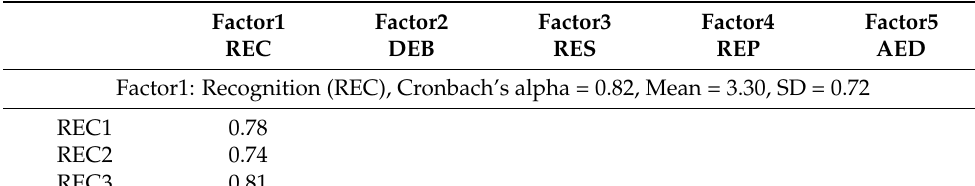
Table 3. Results of EFA for SEFA ( N =